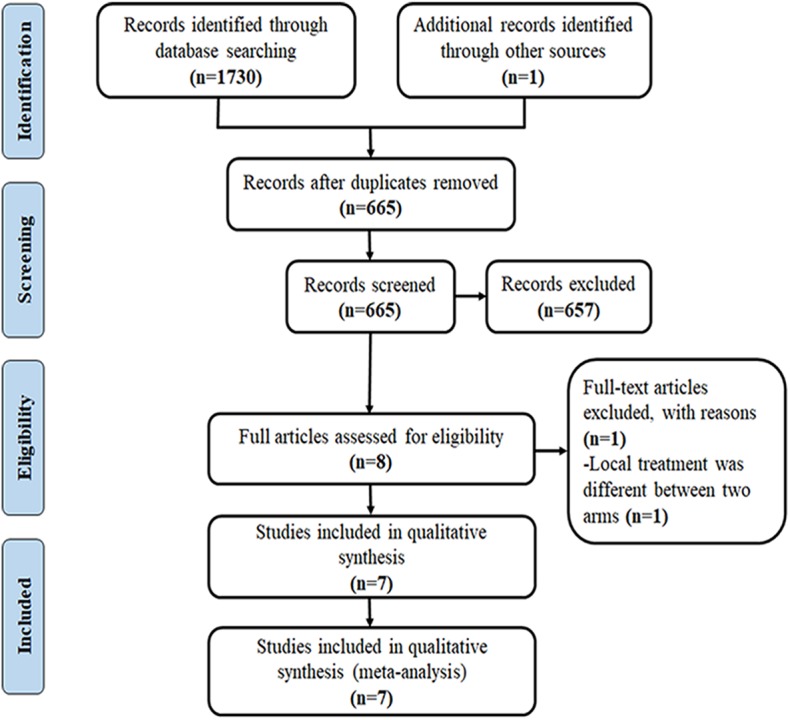
Flow diagram for identification of eligible studies.